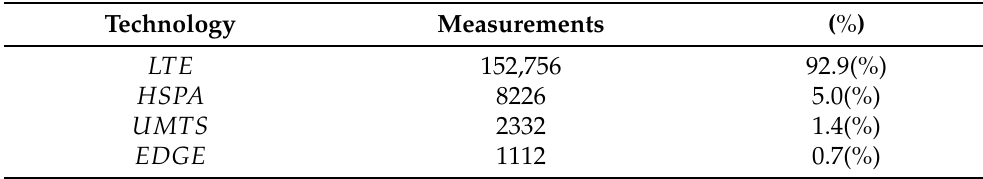
Table 4. Statistics about the access technologies in the